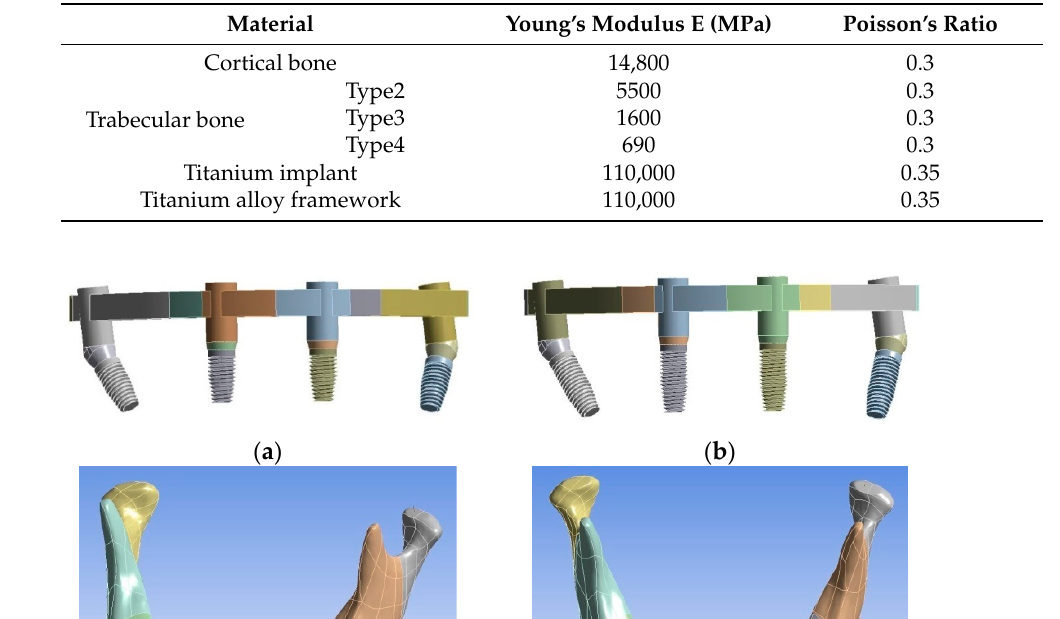
Table 1. Material properties in the FEM model.